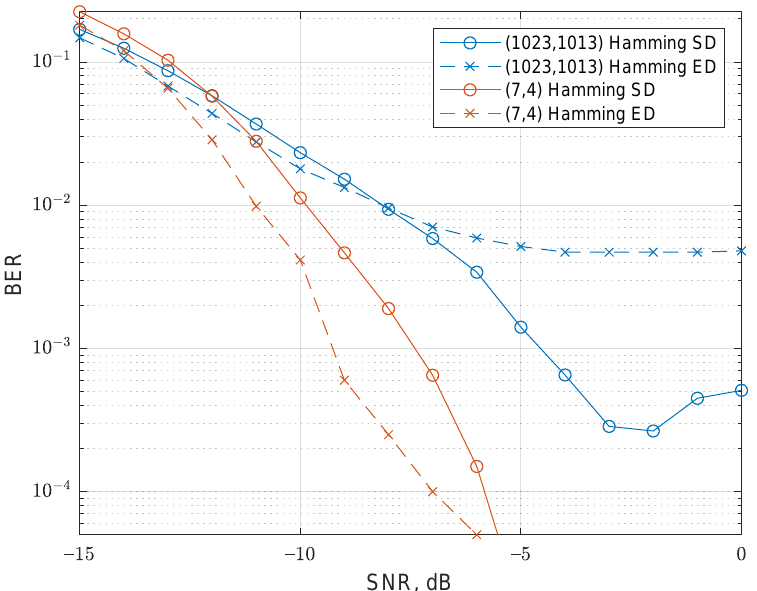
Figure 11. BER versus SNR for data transmission with (1023, 1013) and (7, 4) Hamming codes in FM-ACSK system. SD—strobe-based detector; ED—energy-based detector. FM deviation is 10